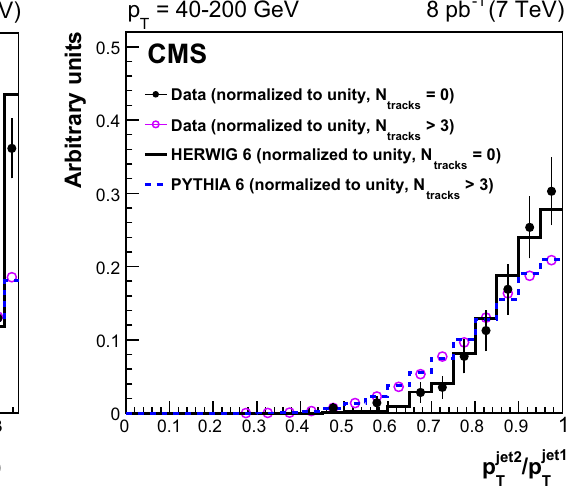
Fig. 5 Distributions, uncorrected for detector effects, of the azimuthal angle Δϕ jet1 , 2 betweenthetwoleadingjets(left)andtheratio p jet2 of the second-leading jet p T to the leading jet p T (right) for events after allselections,withnotracks( N tracks = 0,fullcircles)ormorethanthree